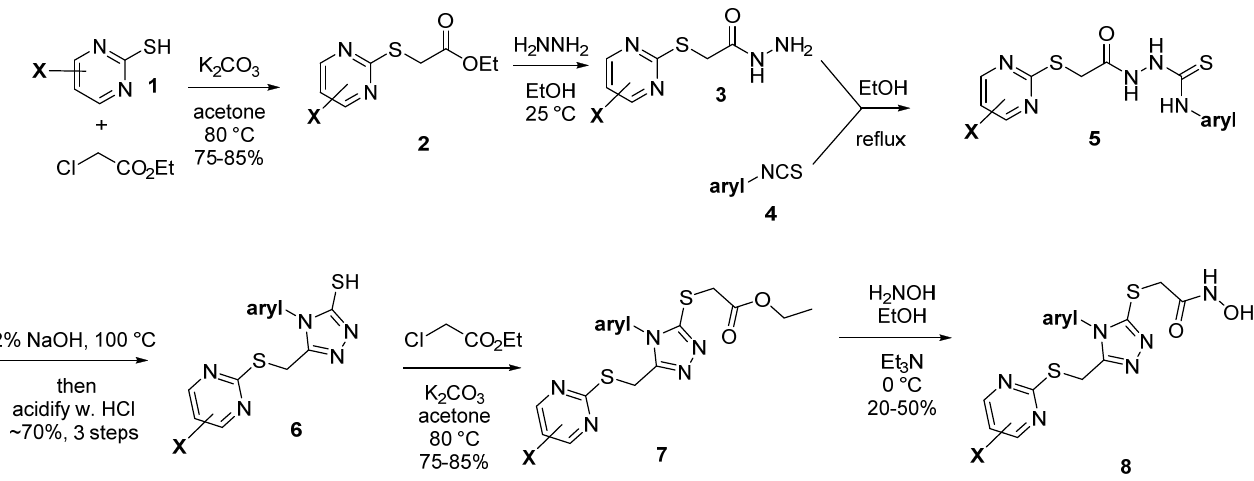
Figure 3. General synthesis scheme.